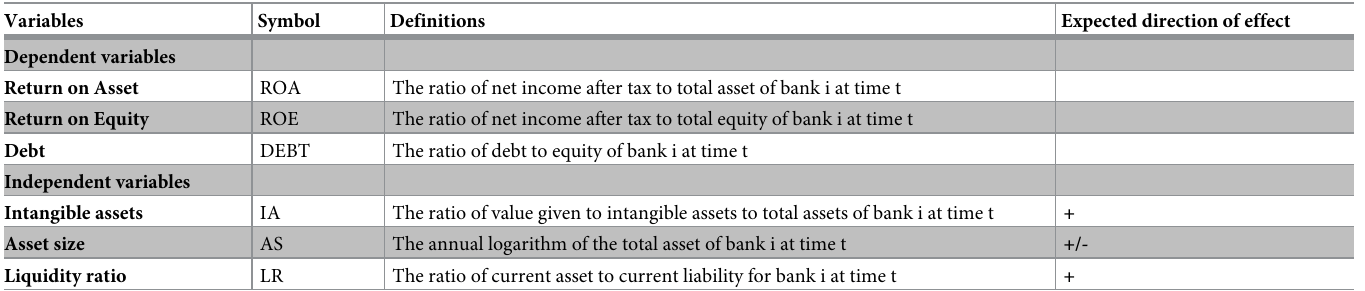
Table 1. Variables and definitions.